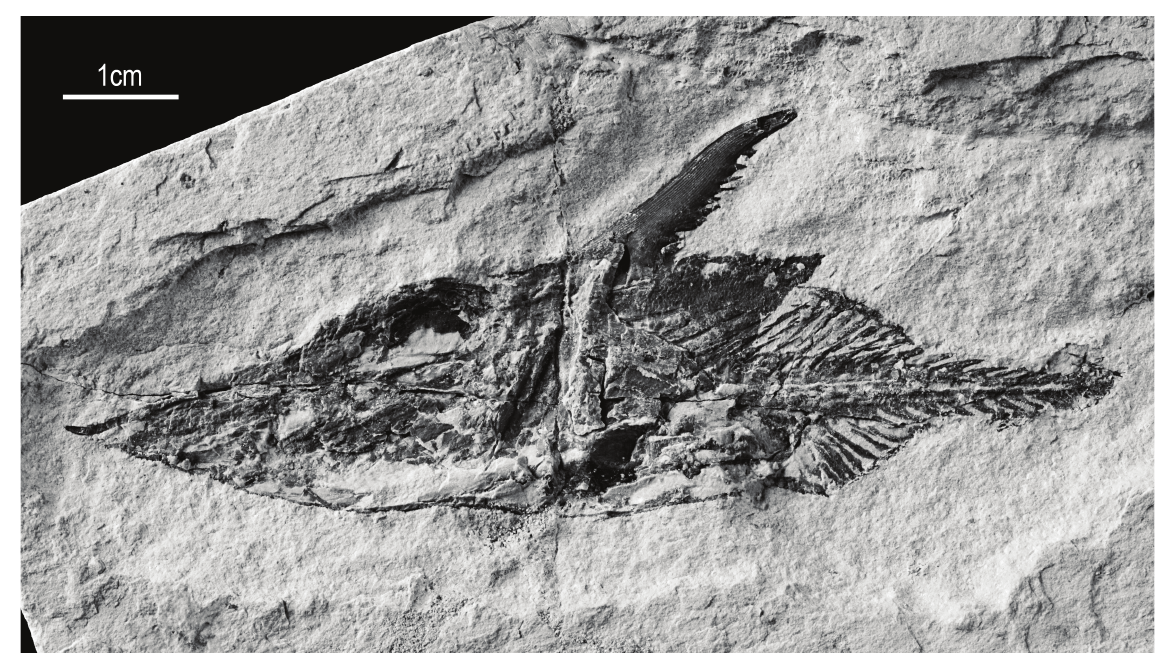
Fig. 2. Joinvillichthys lindstroemi (Davis, 1890). Sample IRSNB N° P 9276.